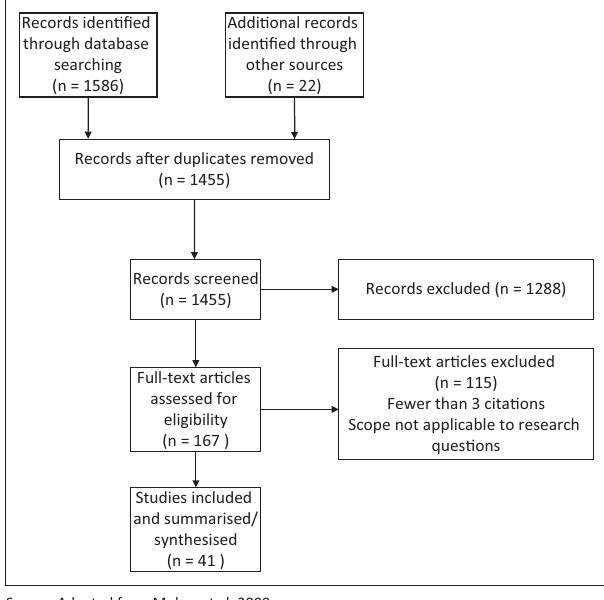
FIGURE 3: Preferred reporting items for systematic reviews and meta-analyses flow diagram.